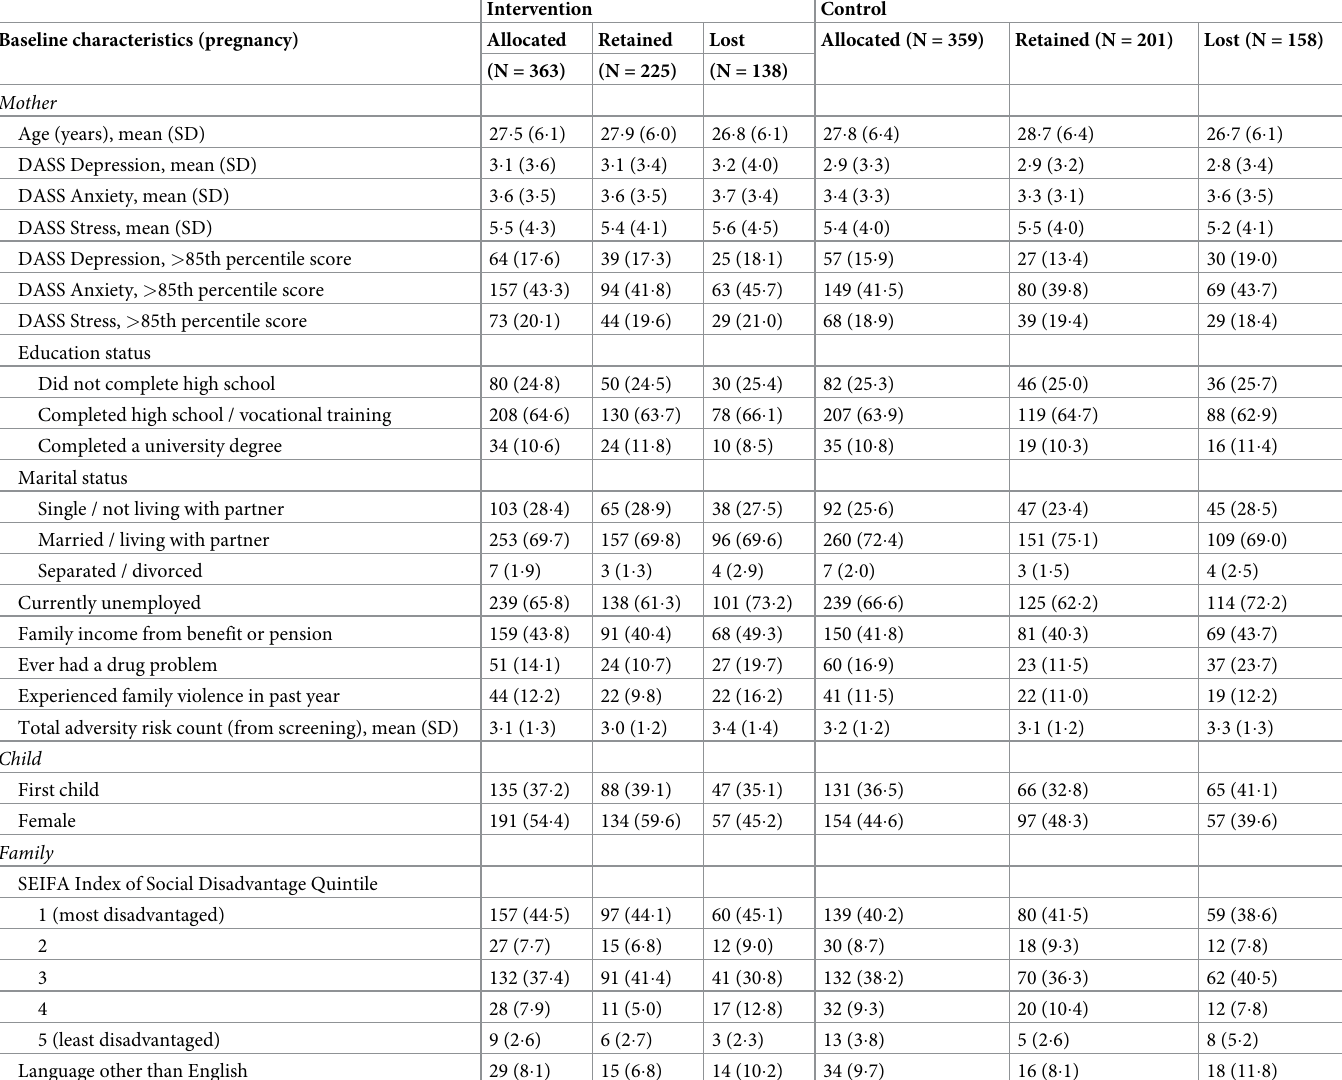
Table 2. Baseline characteristics according to follow-up status (retained or lost to follow-up) at child age 5 years a . Intervention